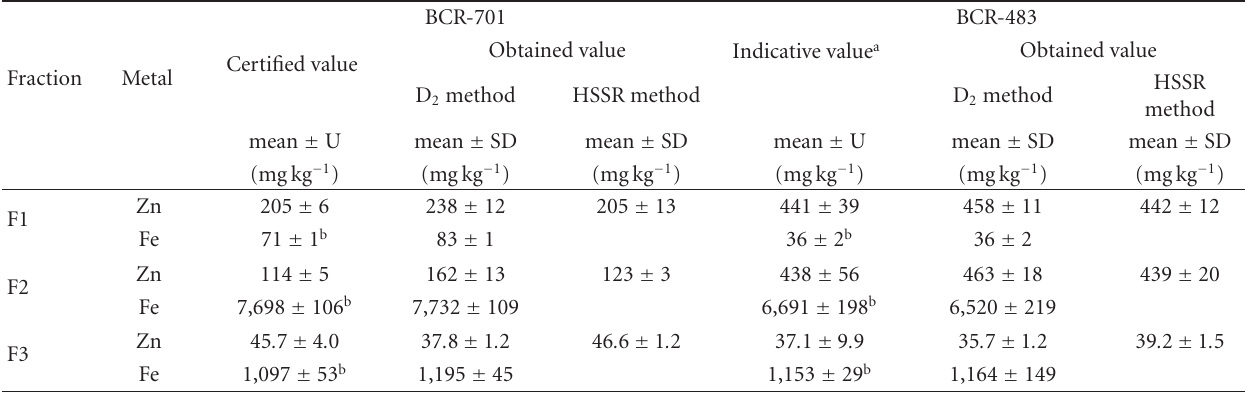
Table 5: Certified and obtained Fe and Zn concentrations in BCR-701 ( n = 3) and BCR-483 ( n = 3) using the BCR three-step sequential extraction procedure.